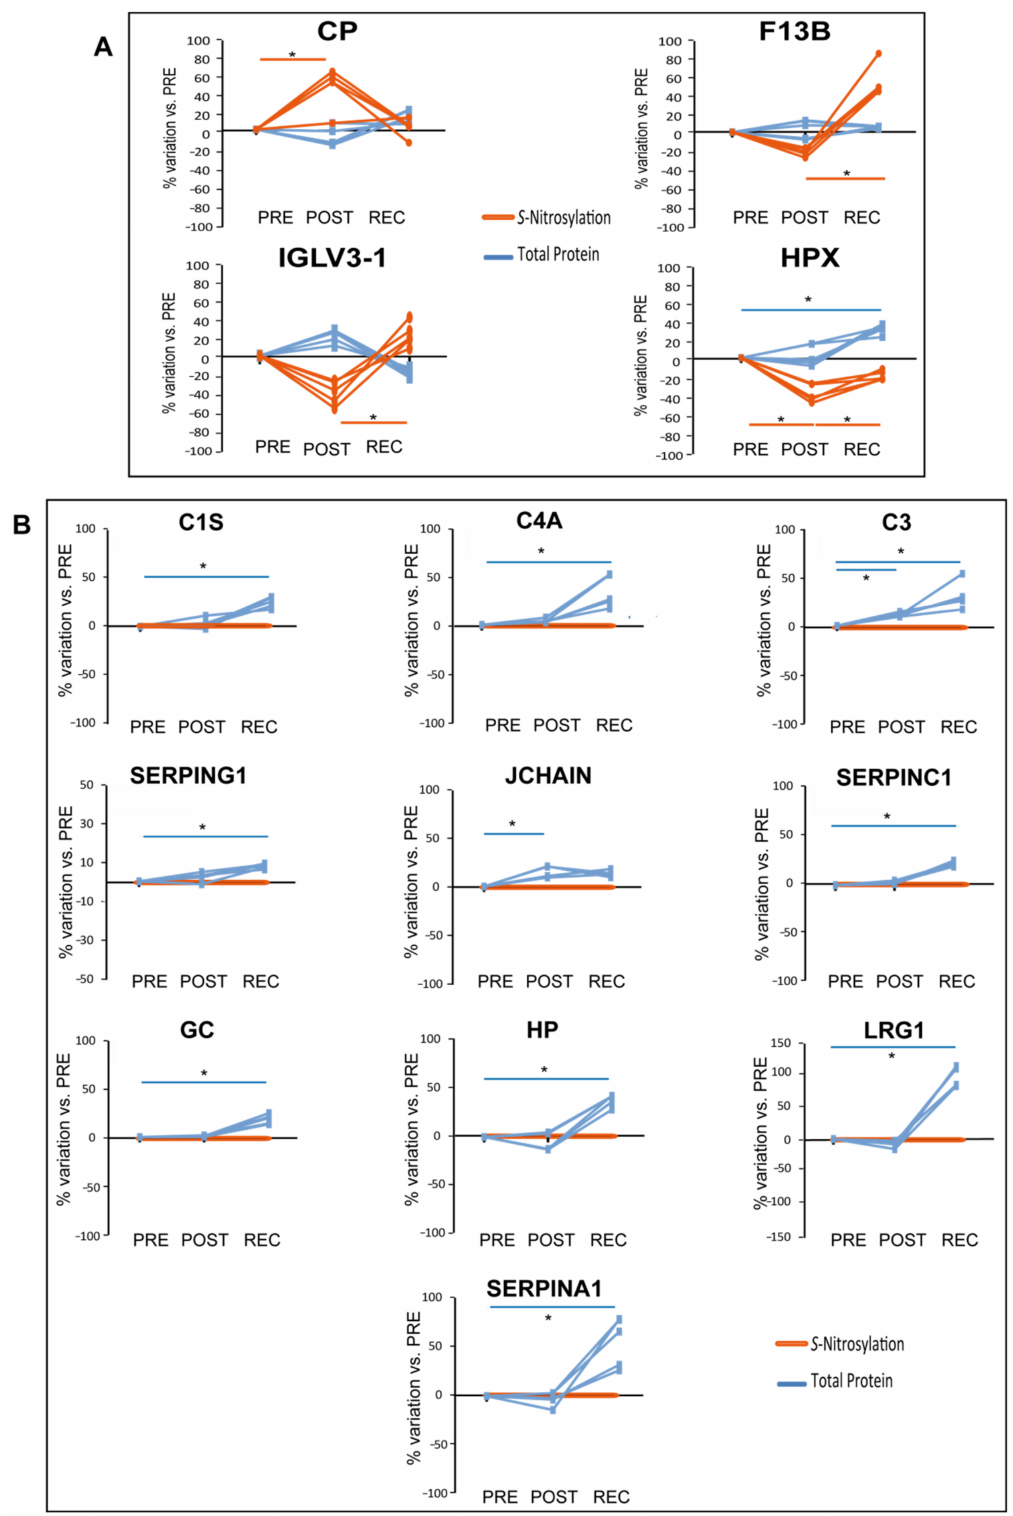
Figure 6. Results from iodoTMT LC-MS/MS proteomic analysis of cocktail-treated subjects. Dif- ferentially abundant proteins from TMT and iodoTMT analyses are expressed as a percentage of variation from PRE. Blue lines refer to total protein, while orange lines to protein S -Nitrosylation. Significant alterations in protein S -nitrosylation ( A ) and significant alteration in total protein levels ( B ). Protein S -nitrosylation levels in ( B ) are normalized to 0% for graphical comparison. (One-way repeated measures ANOVA and Tukey’s test, n = 5, * p -value <